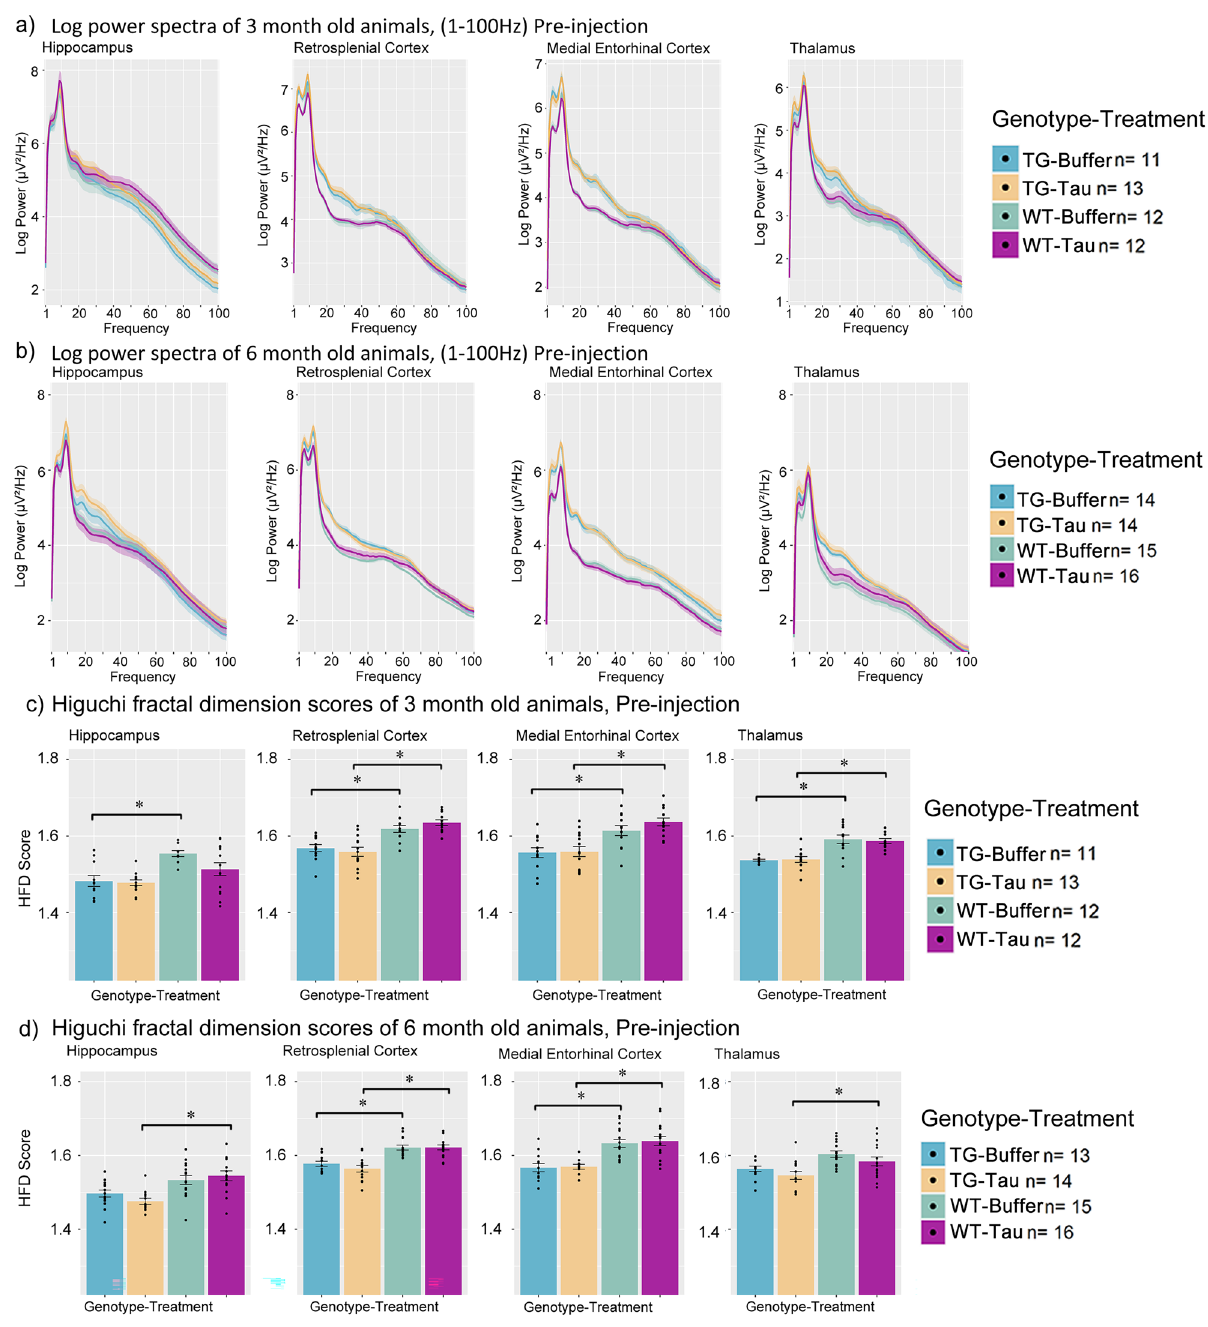
Figure 4. Power spectrum and fractal dimension baseline measures of 3-month-old APP.PS1 and wild-type animals across the hippocampus, retrosplenial cortex, medial entorhinal cortex and thalamus. Log power spectra of APP.PS1 animals and wild-type animals from 1-100 Hz at Pre-injection for ( a ) 3-month-old and ( b ) 6-month-old animals. Bar plots of fractal dimension scores of ( c ) 3-month-old and ( d ) 6-month-old animals at Pre-injection. (m.p.i. refers to months post injection). All bar plots are Mean + SEM. Asterisks indicate significant comparisons ( p < appear to exhibit this difference earlier than buffer injected animals in animals injected at 3 months of age. In animals injected at 6-months of age, this relationship was not significantly present in WT-tau animals, suggesting a differential effect at which age animals were injected. In terms of HFD scores, 6-month-old TG-tau animals showed significant decreases in the hippocampus at 3 m.p.i. and 5 m.p.i. compared to TG-Buffer animals (Fig. 6d, Table 3c). This relationship was noted to be absent prior to injections, suggesting it to be a consequence of tau injections. Significant differences between WT-tau and WT-buffer animals also began to emerge at 5 m.p.i. (Fig. 6d, Table 3c) but paradoxically show increases in